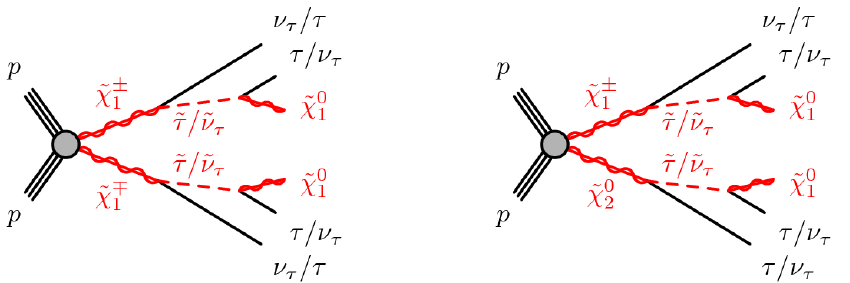
Figure 9: Representative diagrams for the electroweak production and decay pro- cesses of supersymmetric particles considered: (left) ˜ χ + duction [ 16 ] .